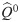
Robustness of estimated EC with respect to the EC density and individual FC.A Fit performance as a function of the density of EC. The blue curve indicates the Q error for optimizations with several masks for C (x-axis); the error bar correspond to the 4 τest > 0. The red curve indicates the similarity between the estimated C and the empirical Q^0. B Similarity of estimated C measured by the Pearson correlation for the different masks in A and τest = 4 s. C Input-output asymmetry of the estimated C obtained for various optimization masks (error bars) and τest (x-axis). The red curve corresponds to LO and the purple curve to the heuristic method. The blue curve indicates the asymmetry of the empirical FCτ. D
Q Error for LO based on individual FCs with τest = 2 and 4 s with 32% density. The horizontal dashed line corresponds to the Q error in Fig 7. E Similarity between the individual ECs and the EC obtained from the mean FC in Fig 7F. Similarity is measured by the Pearson correlation between the non-zero EC weights for the 32% density mask. F EC asymmetry of the individual ECs. The horizontal dashed line indicated the asymmetry of the EC in Fig 7F. G Agreement between the mean EC over individual FCs and the EC estimated from the mean FC.